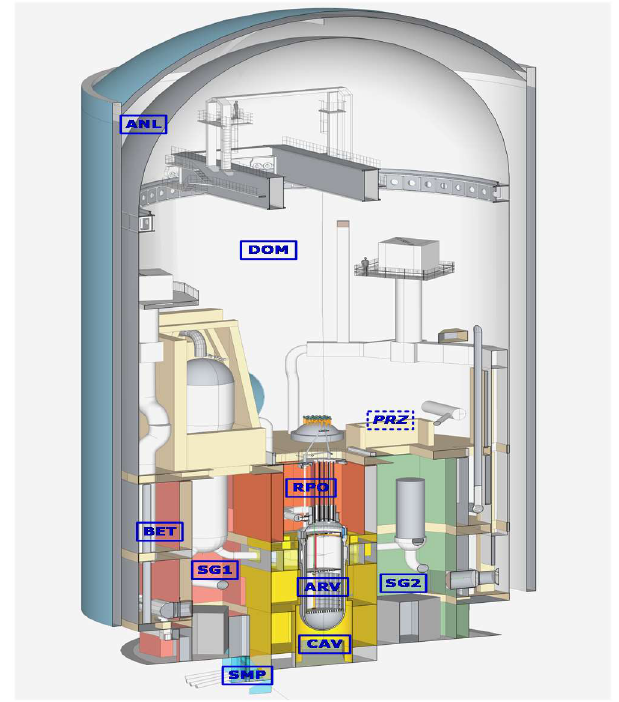
Figure 1. Nuclear power plant (NPP) Krško containment outline.